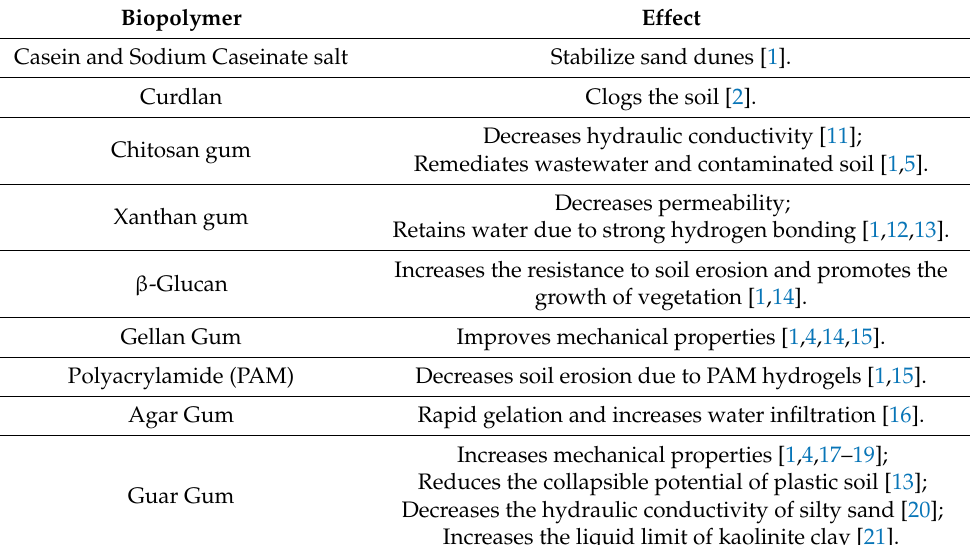
Table 1. Effect of common biopolymers on soil